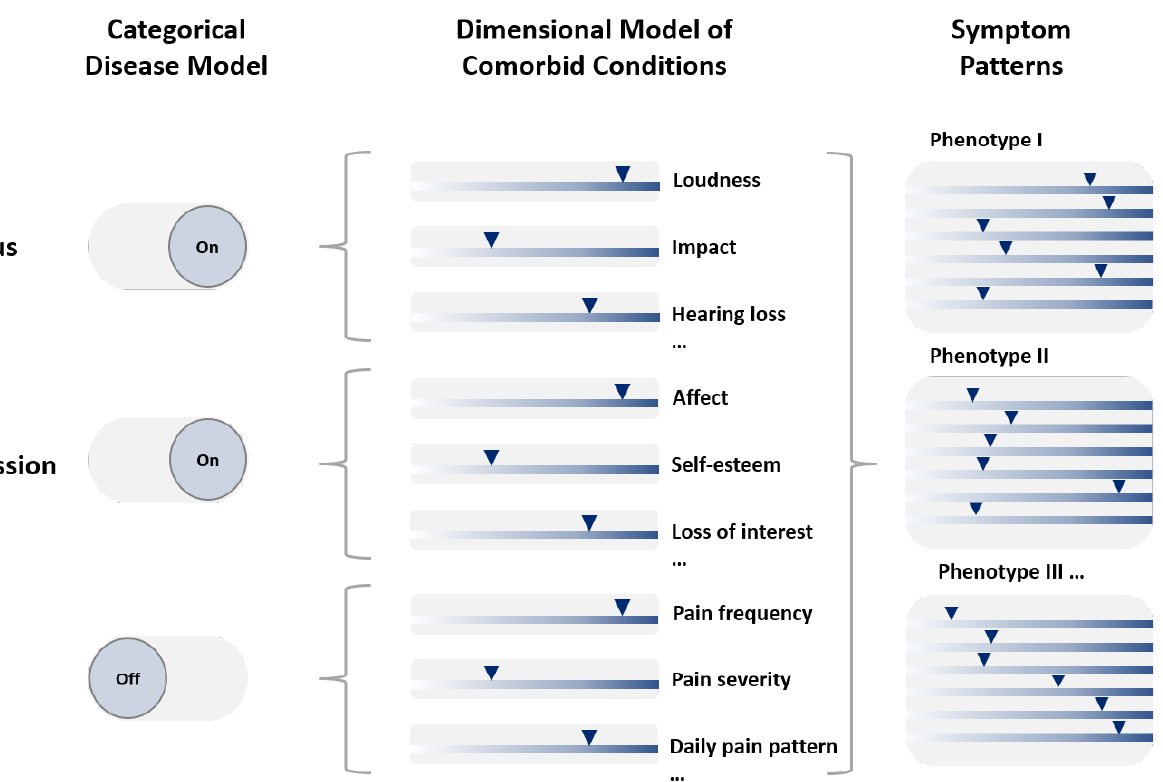
Figure 2. From categorical disorder models to phenotypes of symptom patterns. The same compi- lation of individual symptoms and their parameter values ( middle column) would lead to binary categories in the categorical disorder model ( left ), whereas the systems medicine approach favoured here would lead to different phenotypes specific for an individual patient. Note that whereas in the categorical disorder model (in the example given) pain-related symptoms would be neglected, and all data would contribute to the individual phenotypes in the new approach. Triangles depict individual scores for a given dimension or symptom.